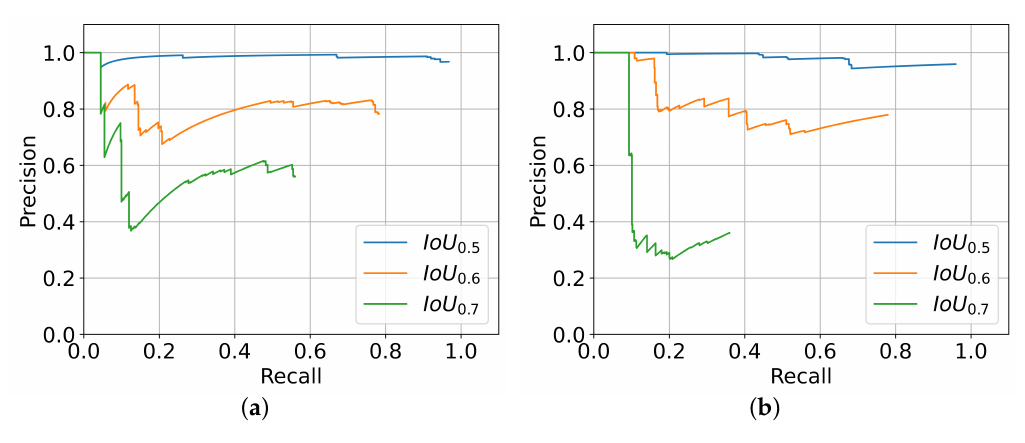
Figure 8. precision-recall graph: ( a ) Video 1; ( b ) Video 2. Table 1. average